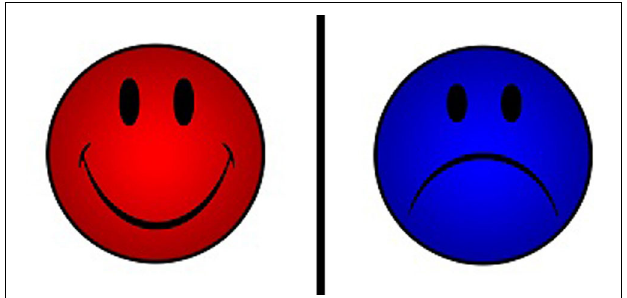
FIGURE 1 | Target cards for the EM-DCCS